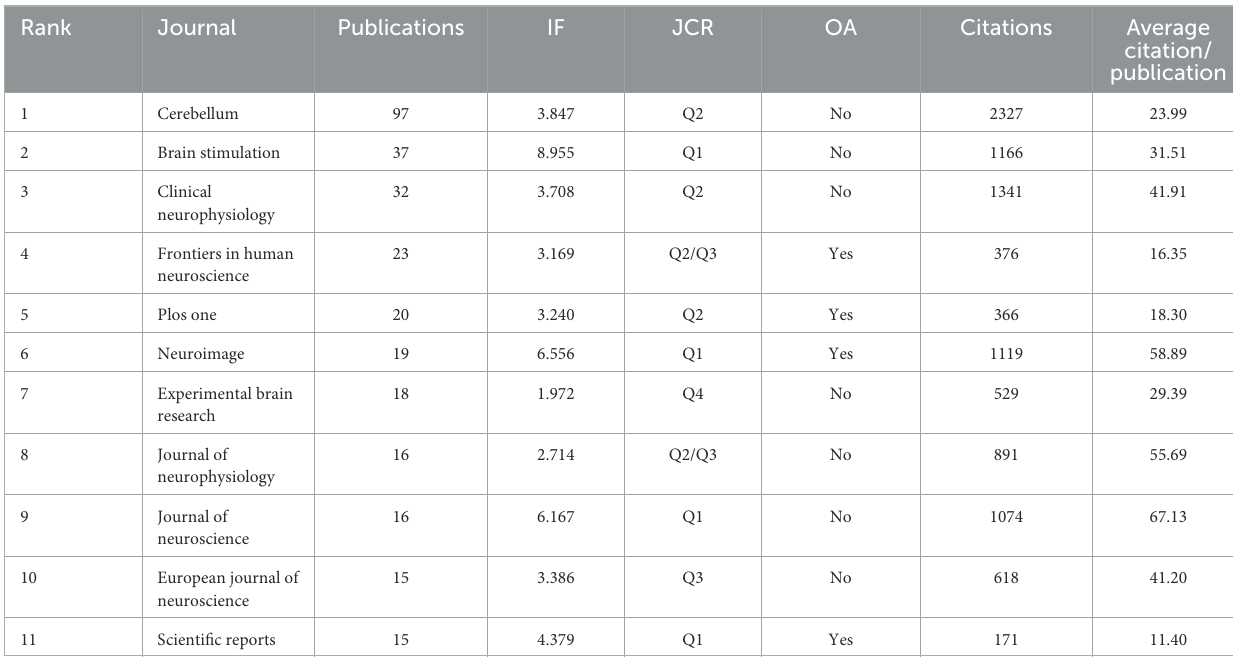
TABLE 2 The top 11 journals that published articles on NICS